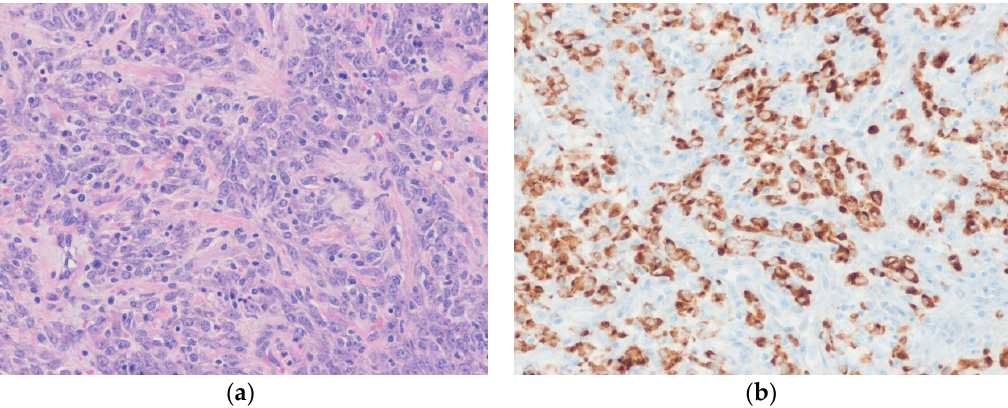
Figure 6. Epithelioid inflammatory myofibroblastic sarcoma. ( a ) The tumor cells are round to epithelioid-shaped and have prominent nucleoli, with mild infiltration of inflammatory cells, including neutrophils and lymphocytes. ( b ) The tumor cells show nuclear membranous staining for ALK (H&E stain, original magnification 200× a ; ALK immunostain, original magnification 200× b